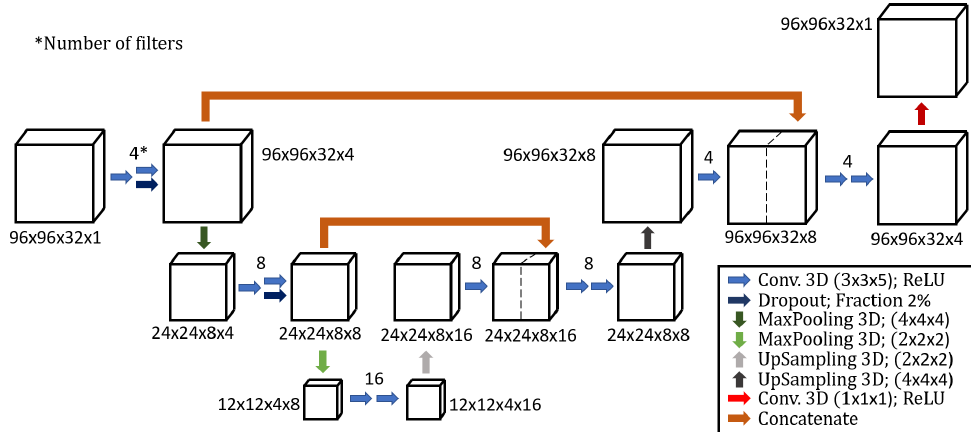
Figure 3. Sketch of the 3D U-Net architecture, with all the building blocks and filter types. The legend inset in the lower right hand side corner shows the color code for the activation